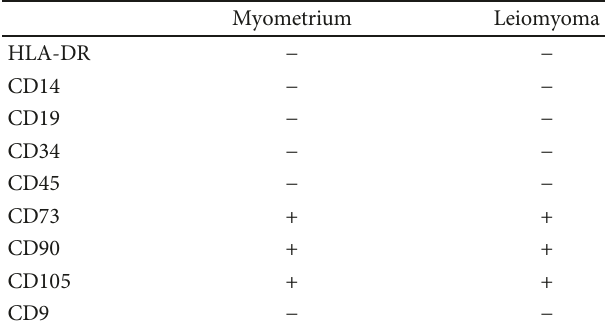
Table 2: Flow cytometry results of progenitor